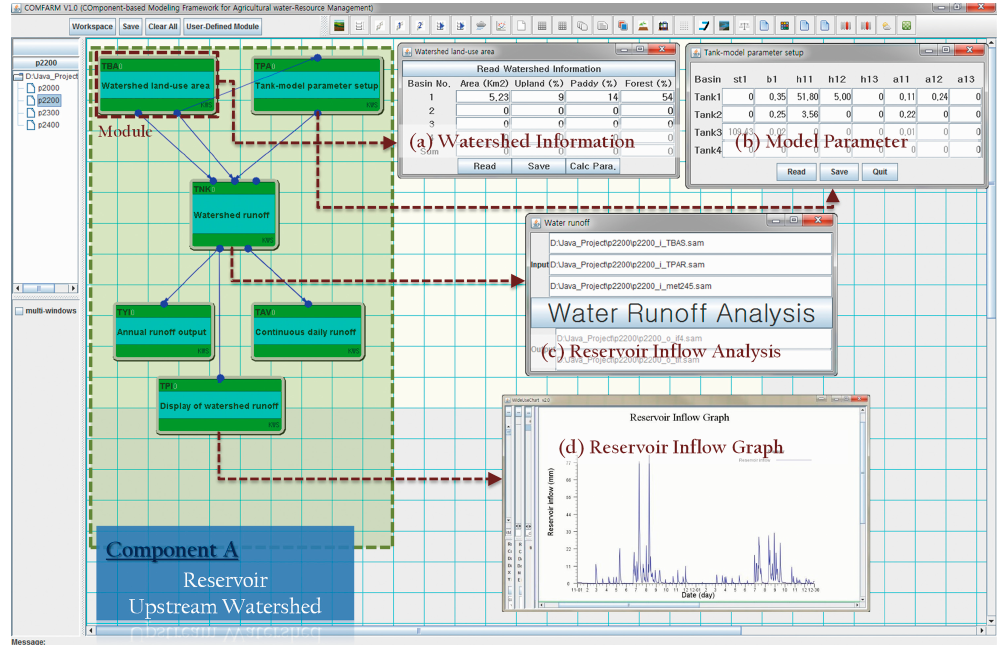
Figure 6. Upstream ‐ watershed reservoir. Dialog boxes: ( a ) reads watershed information such as the watershed area and ratio of paddy, forest, and field; ( b ) determines the parameters of the hydrological model for the analysis of the reservoir inflow; ( c ) analyzes reservoir inflow from upstream watershed; and ( d ) plots the resulting reservoir inflow data in a graph.